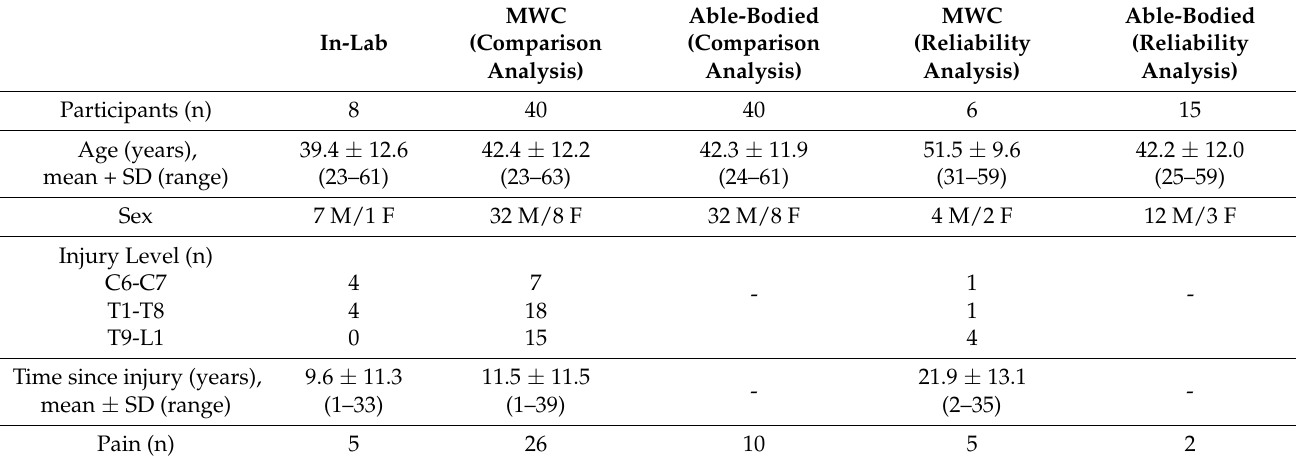
Table 1. In-lab and free-living (Manual Wheelchair (MWC) and able-bodied individuals) participant demographics. M = Males, F = Females.